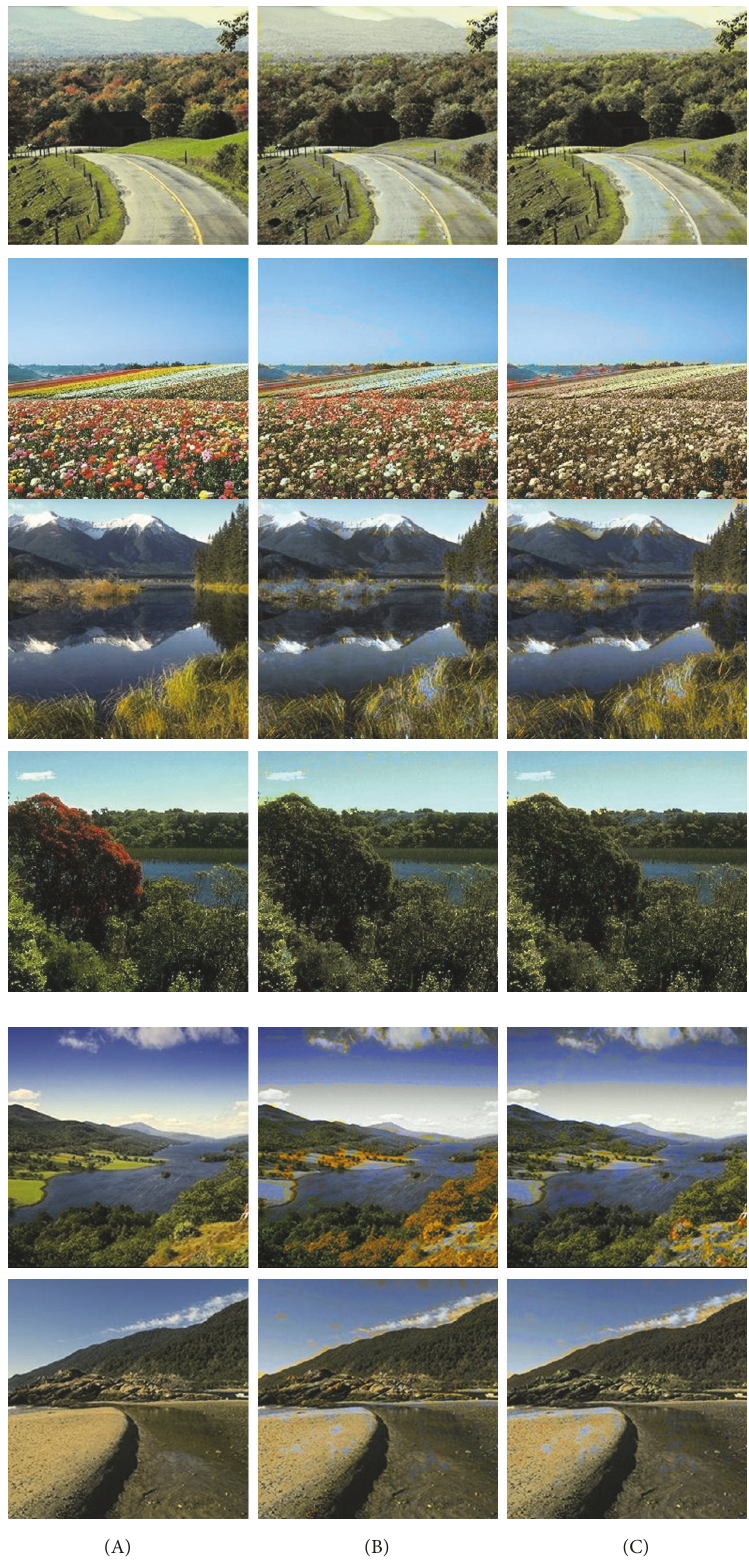
Figure 6: Color images (A) and recovered images using learned feature vectors after E-step (B) and M-step